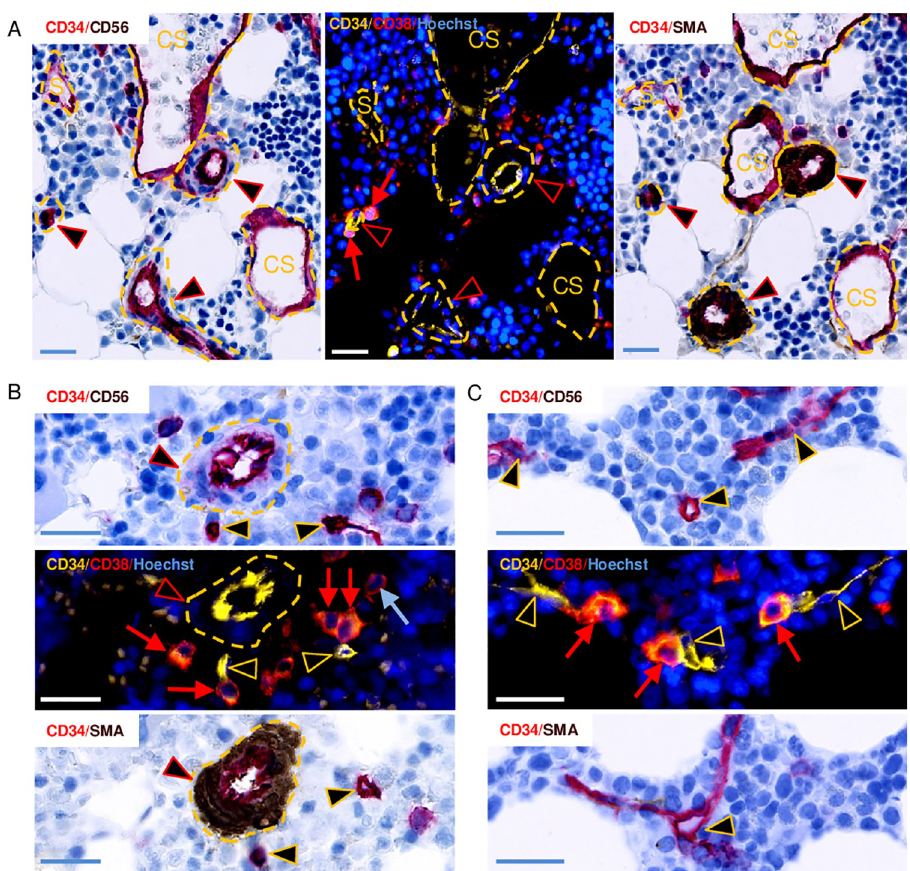
Fig 5. Illustrations of vascular structures including arteries and capillaries that are positioned within a distance of 30 μ m from progenitors. The representative images are obtained from three different biopsies that were multiplex- stained as indicated. The three panels (A, B, C) each show three adjacent sections. Each pure fluorescence staining is shown between two immunohistochemistry stainings. (A) Two progenitors (red arrows at the left of the middle image) in contact with a small artery, three CD34 + /CD38 - /SMA + and CD56 - arteries (red arrowheads), a patchy CD34-stained sinusoid (S and dashed yellow line), and two (left and middle), and three (right) CD34-stained collecting sinusoids (CS and dashed yellow line). (B) Four progenitors and a more differentiated cell profile (blue arrow), a CD34 + /CD38 - / SMA + and CD56 - artery, and two capillary cross-sections (yellow arrowheads). (C) Contact between three progenitors and several segments of a capillary that ramifies in different directions. Note that the capillary has a narrow lumen and that is does not have a continuous layer of SMA + SMCs. Scale bars = 10 μ